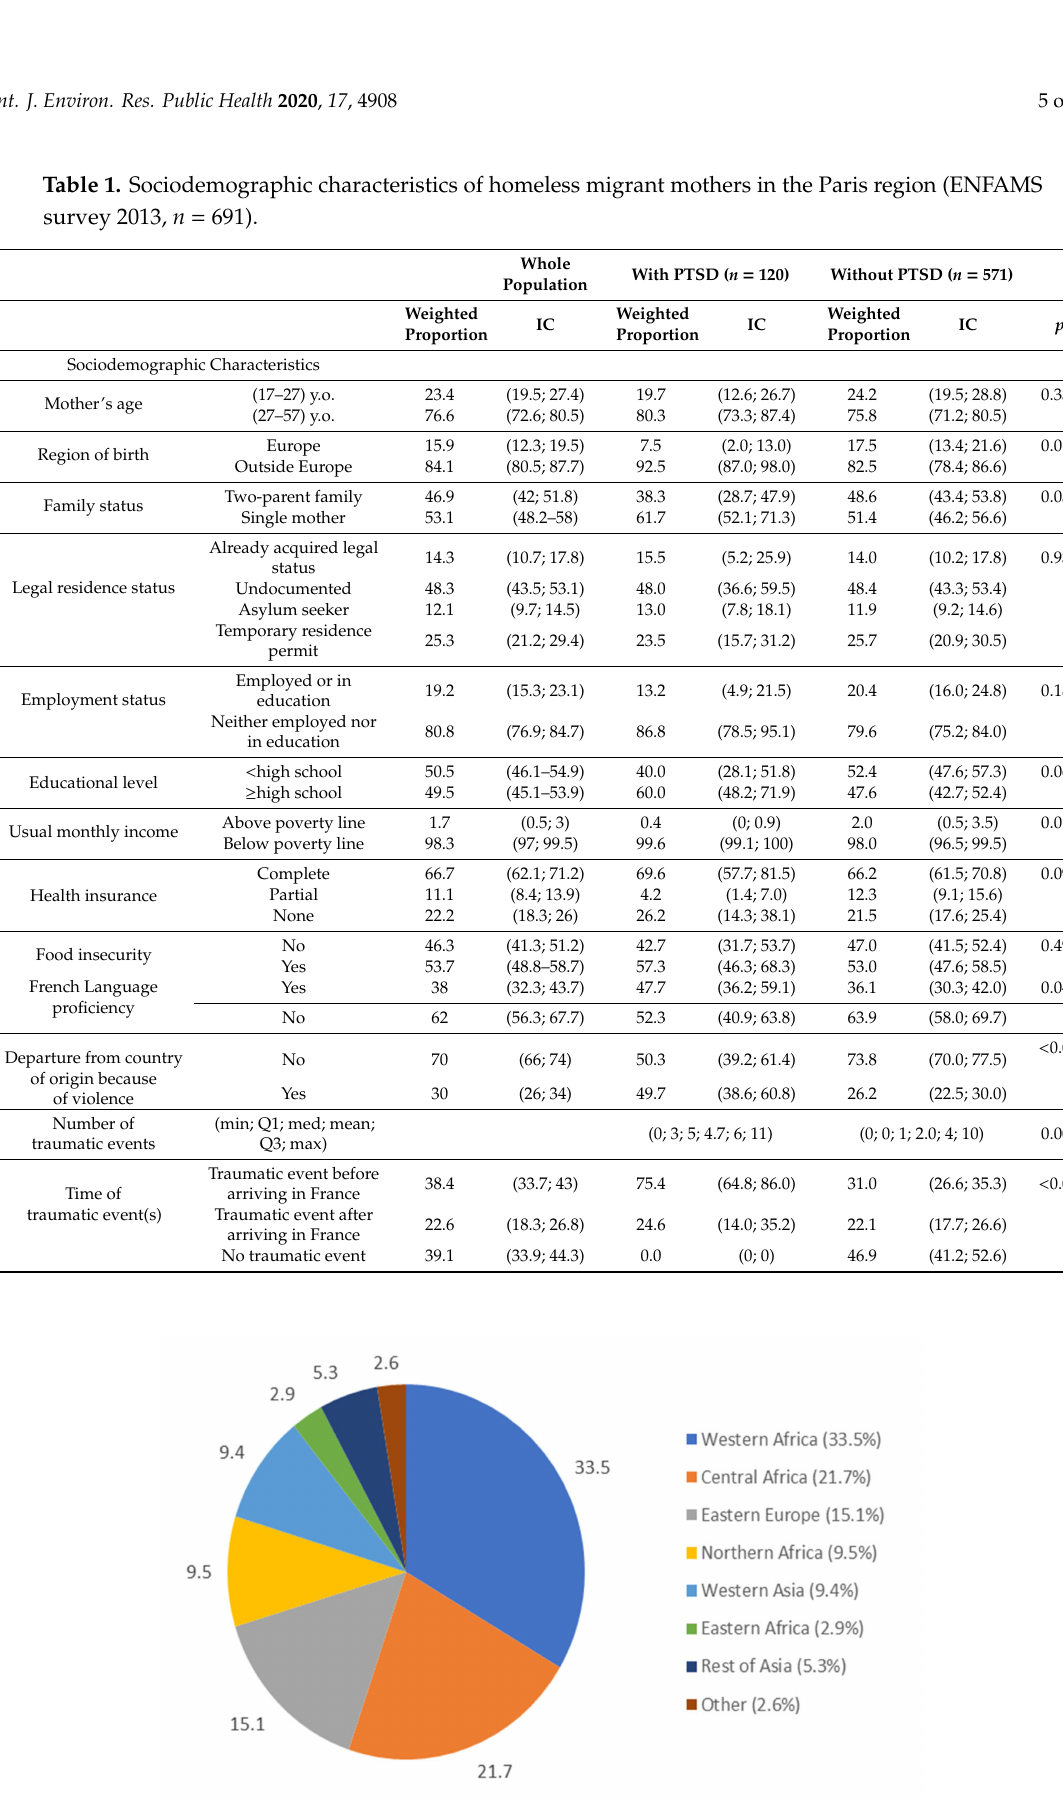
Figure 1. Country of origin of migrant homeless mothers in the Paris region (The “ enfants et familles sans logement ” (ENFAMS; “homeless children and families”) survey 2013, n =